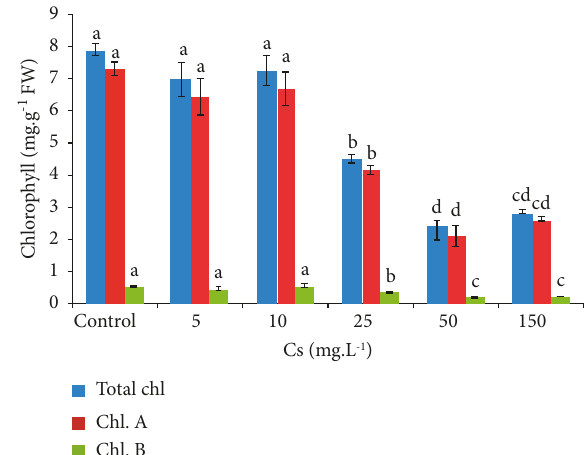
Figure 4: Effect of cesium on chlorophyll content of S. portulacastrum . All the values are mean of twelve readings ± S.E. One-way ANOVA significant at p ≤ 0.05. Different letters indicate significantly different values in total chlorophyll, chlorophyll-a, or chlorophyll-b (DMRT p ≤